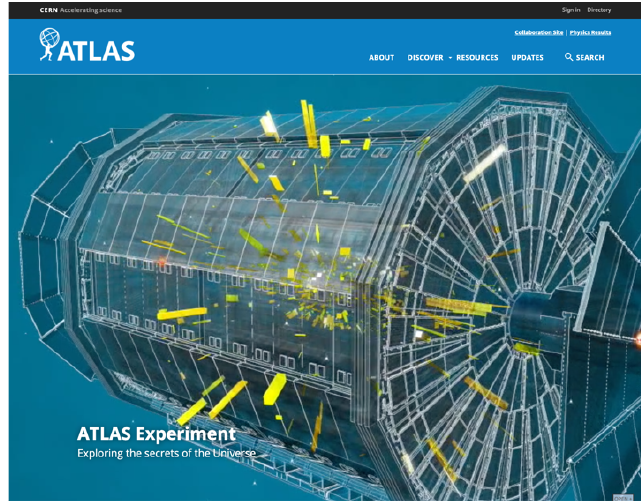
Figure 2. Potential home page video layout using Landing Page content